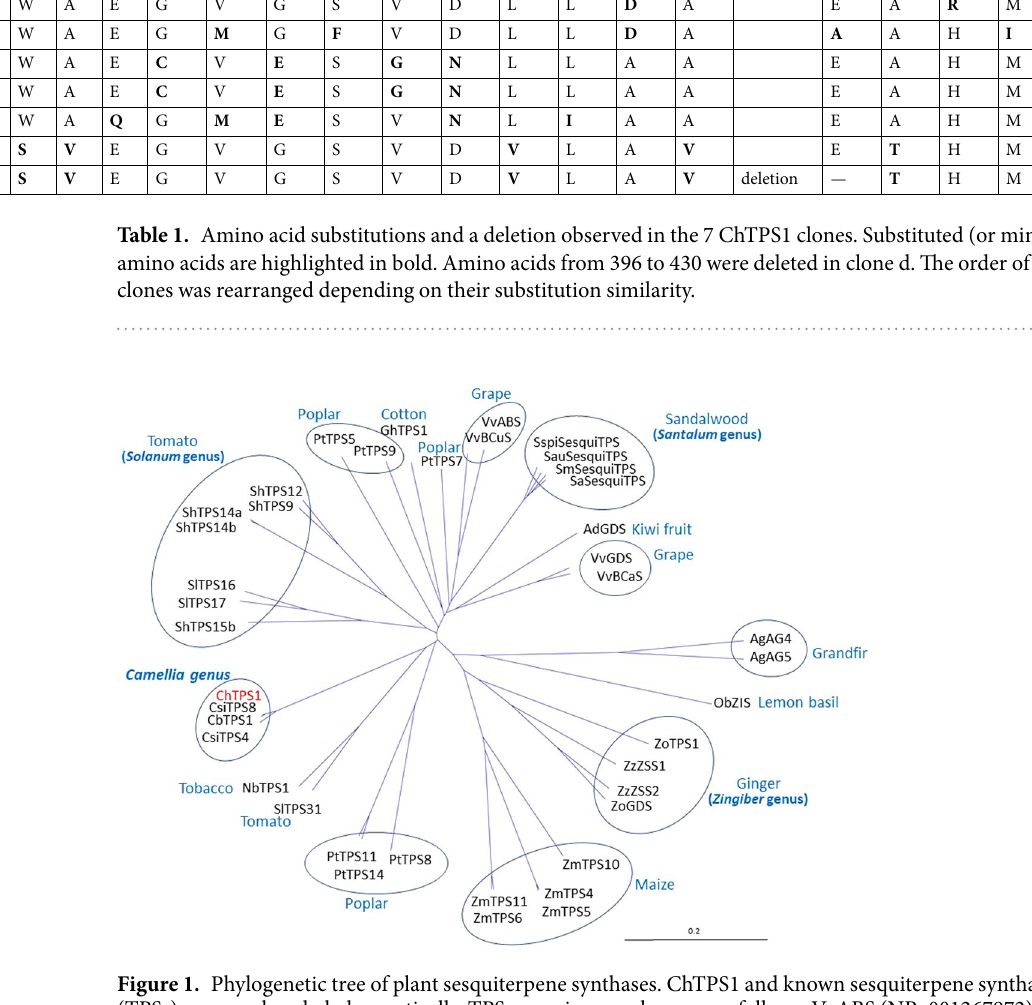
Figure 1. Phylogenetic tree of plant sesquiterpene synthases. ChTPS1 and known sesquiterpene synthases (TPSs) were analyzed phylogenetically. TPS accession numbers are as follows: VvABS (NP_001267972), VvBCaS (ADR74193), VvBCuS (ADR74200), VvGDS (Q6Q3H3), AdGDS (AAX16121), ZzZSS1 (BAG12020), ZzZSS2 (BAG12021), ZoGDS (AAX40665), ZoTPS1 (BAI67934), ZmTPS4 (AAS88571), ZmTPS5 (AAS88574), ZmTPS6 (AAS88576), ZmTPS10 (AAX99146), ZmTPS11 (ACF58240), ObZIS (AAV63788), AgAG4 (AAC05727), AgAG5 (AAC05728), PtTPS5 (KF776503), PtTPS7 (KF776505), PtTPS8